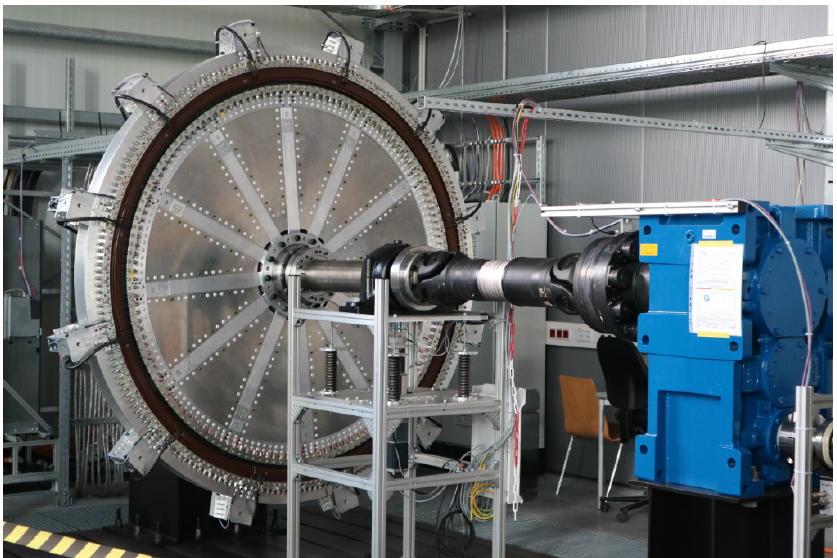
Figure 1. Scaled down low voltage demonstration